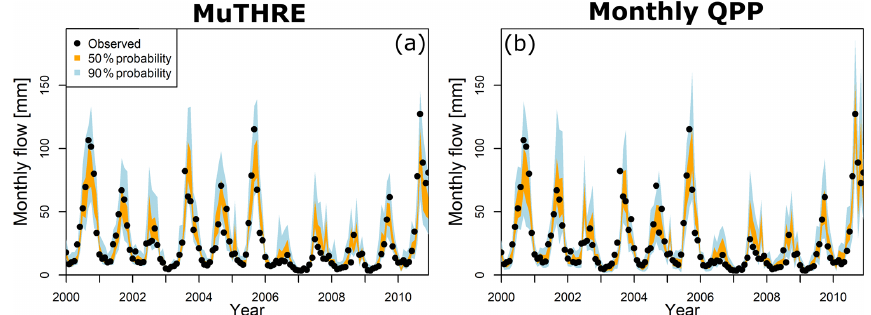
Figure 6. Time series of monthly probabilistic forecasts for Murray River at Biggara (401012; see Fig. 3), for the seamless MuTHRE model and non-seamless monthly QPP model. Results are shown between the years 2000 and